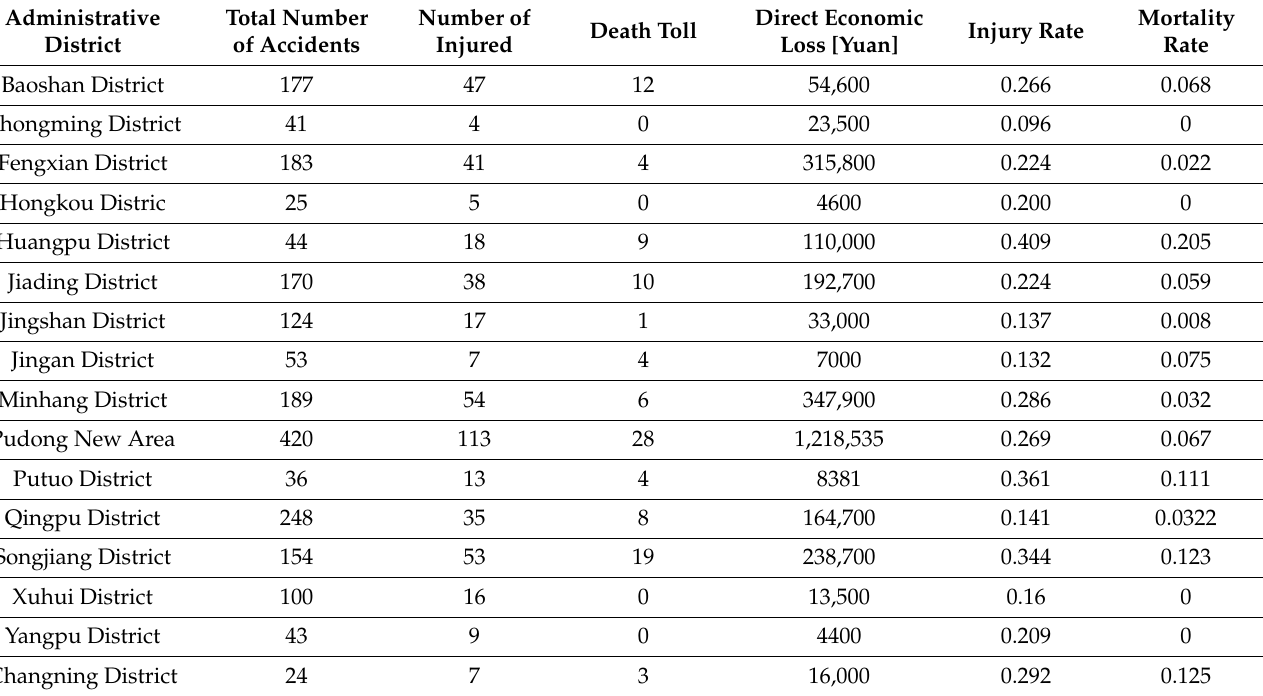
Table 2. Descriptive statistics of traffic accidents in different administrative